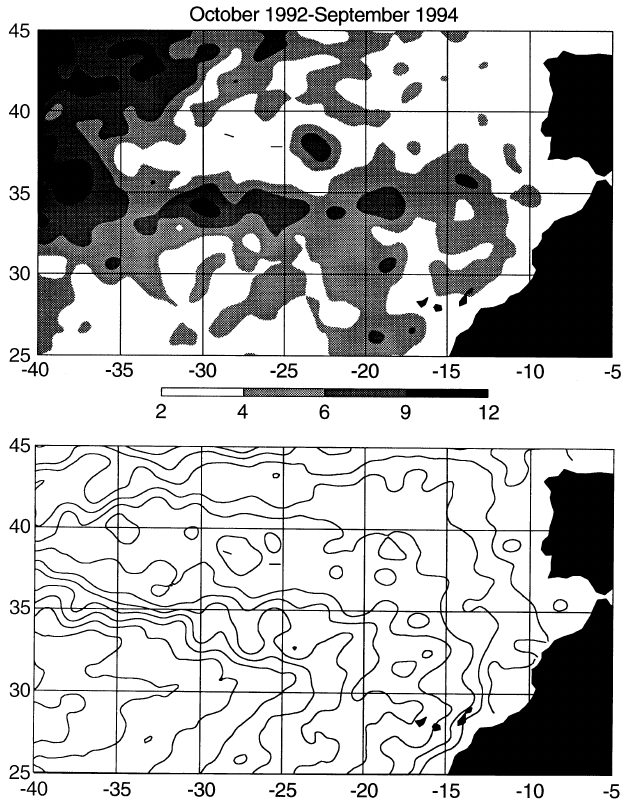
Fig. 9. a Map of the sea-level Rms variability over the two years of satellite observations (in cm); b mean sea-surface topography for the same period (CI: